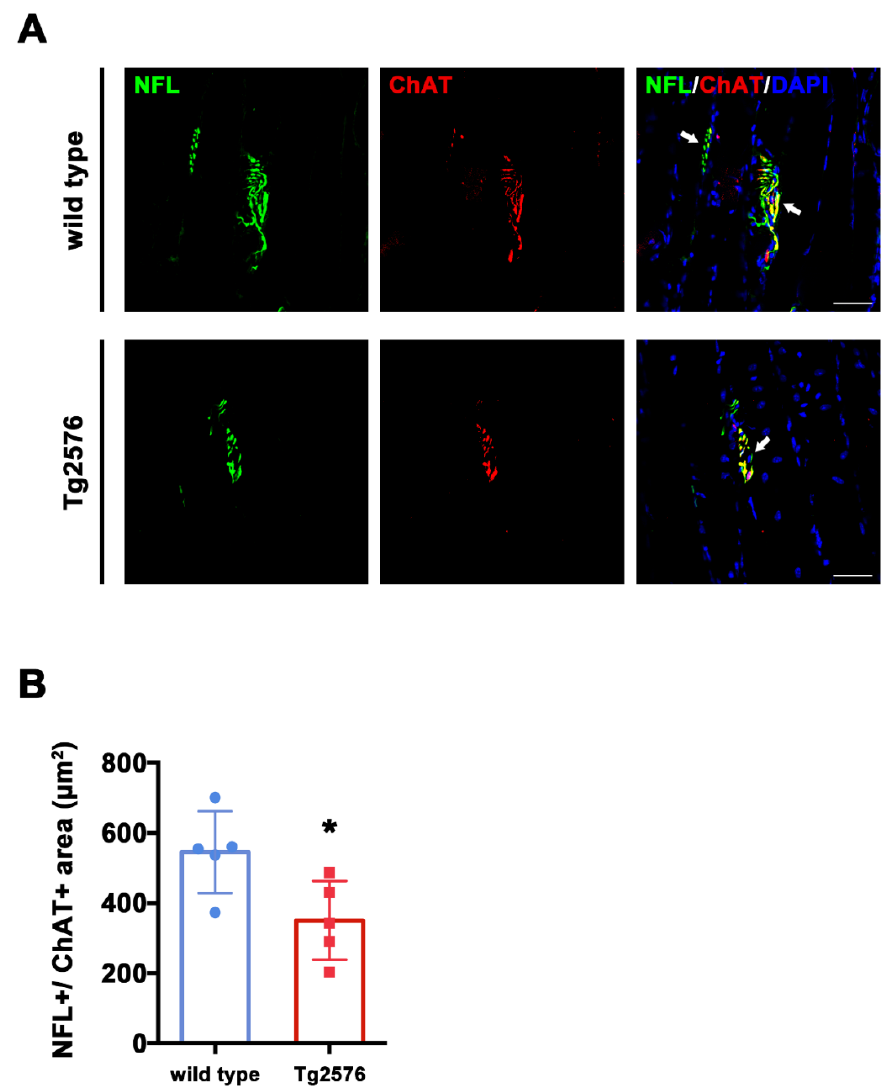
Figure 3. Tg2576 mice exhibit reduced ChAT + area in pre-synaptic terminals of TA muscles. ( A ) Representative images of TA sections, stained with antibodies anti-NFL (green) and anti-ChAT (red), from Tg2576 and wild type mice. Sections were counterstained with DAPI in order to detect cell nuclei. White arrows point to pre-synaptic area, positive for both markers. Scale bar = 50 µm. ( B ) Histogram reporting the average area of ChAT signal in pre-synaptic surface, identified by the presence of both NFL and ChAT signals, in TA sections of Tg2576 and wild type mice ( n = 5 mice per genotype). Unpaired t test was used for comparison (* = p < 0.05).